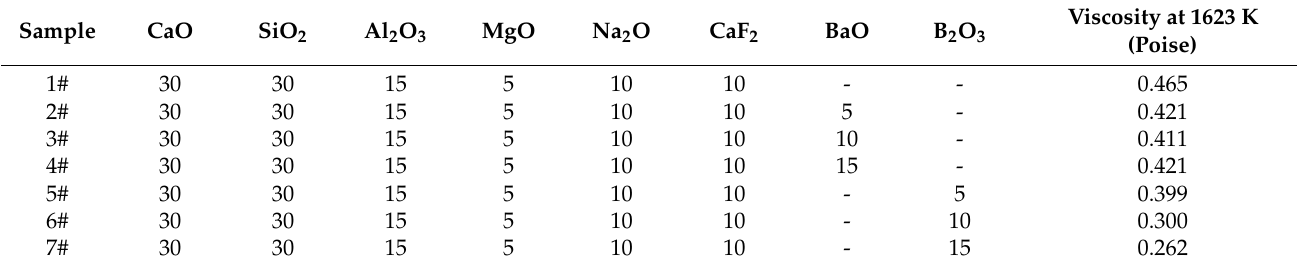
Table 1. Chemical composition of experimental mold fluxes (mass percentage).